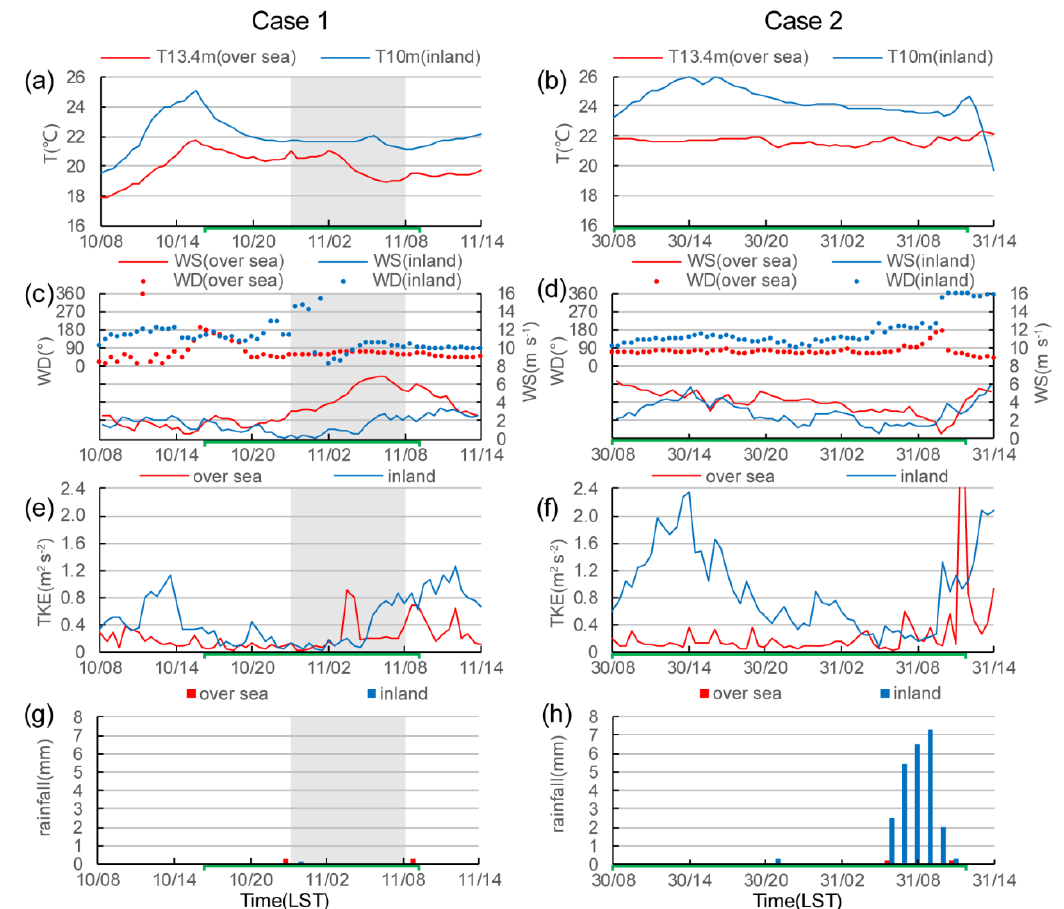
Figure 11. Meteorological parameters and turbulence characteristics of case 1 (left column) and case 2 (right column) over sea and inland. ( a , b ) T10m = air temperature at 10 m AGL, T13.4m = air temperature at 13.4 m MSL. ( c , d ) WD, WS; ( e , f ) TKE; ( g , h ) rainfall = the rainfall in an hour. The green line indicates the sea-fog period, the grey shading indicates the inland-fog period.